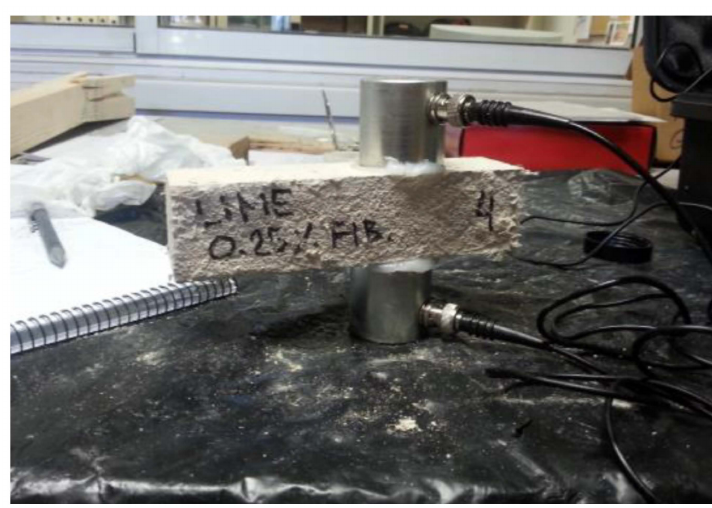
Figure 15. Longitudinal ultrasonic measurement.